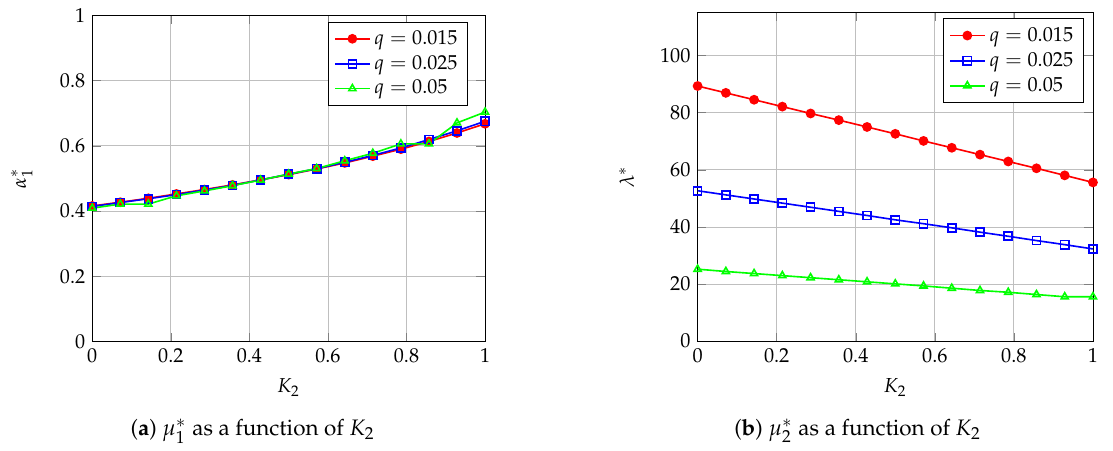
Figure A3. α ∗ and λ ∗ a function of K 2 with K 1 = 1